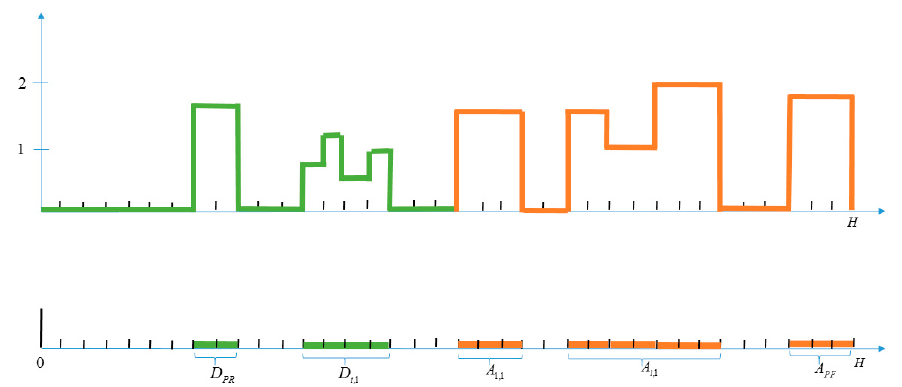
Figure 7. Disassembly-assembly schedule planning with the representation of levels of machine solicitation on the time scale.